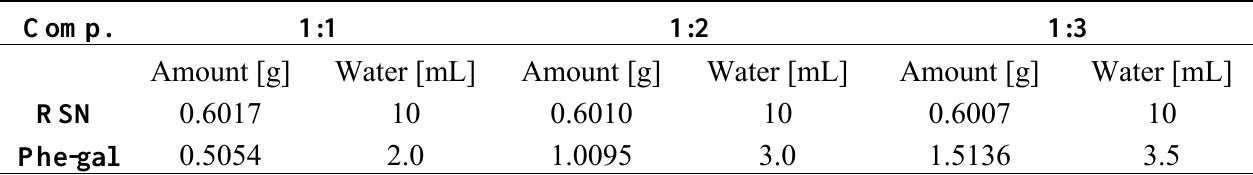
Table 1. Risedronate (RSN) and phenyl- β - D -galactopyranoside (Ph-gal) in ratios 1:1, 1:2 and 1:3 (samples 1 - 3 ).